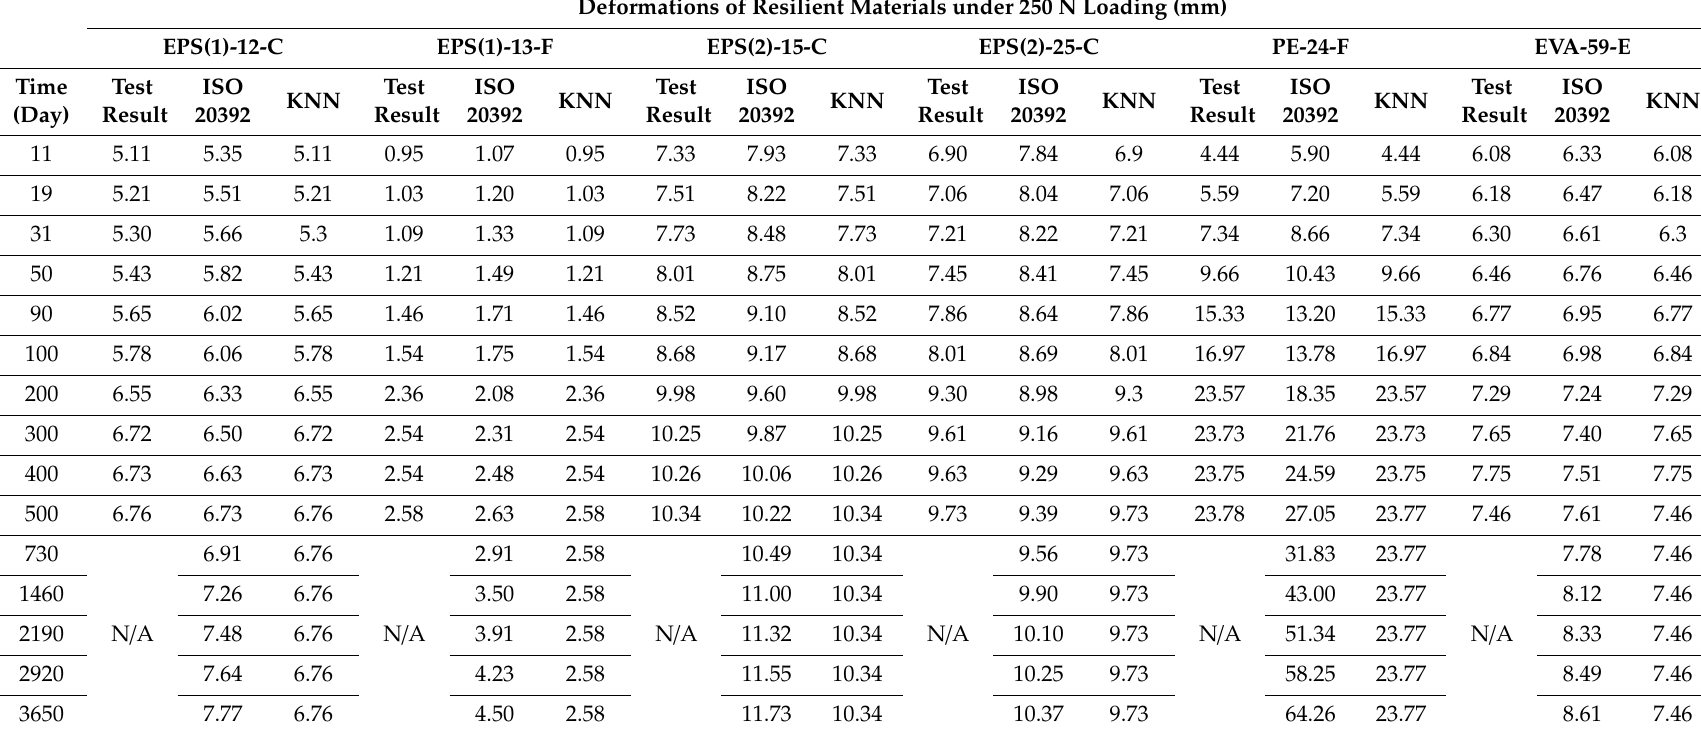
Table 4. Deformations of resilient materials under 250 N